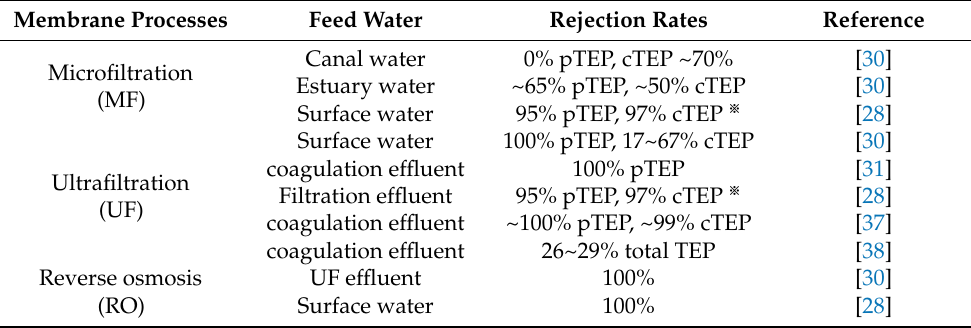
Table 3. The removal of TEP by different membrane processes reported in